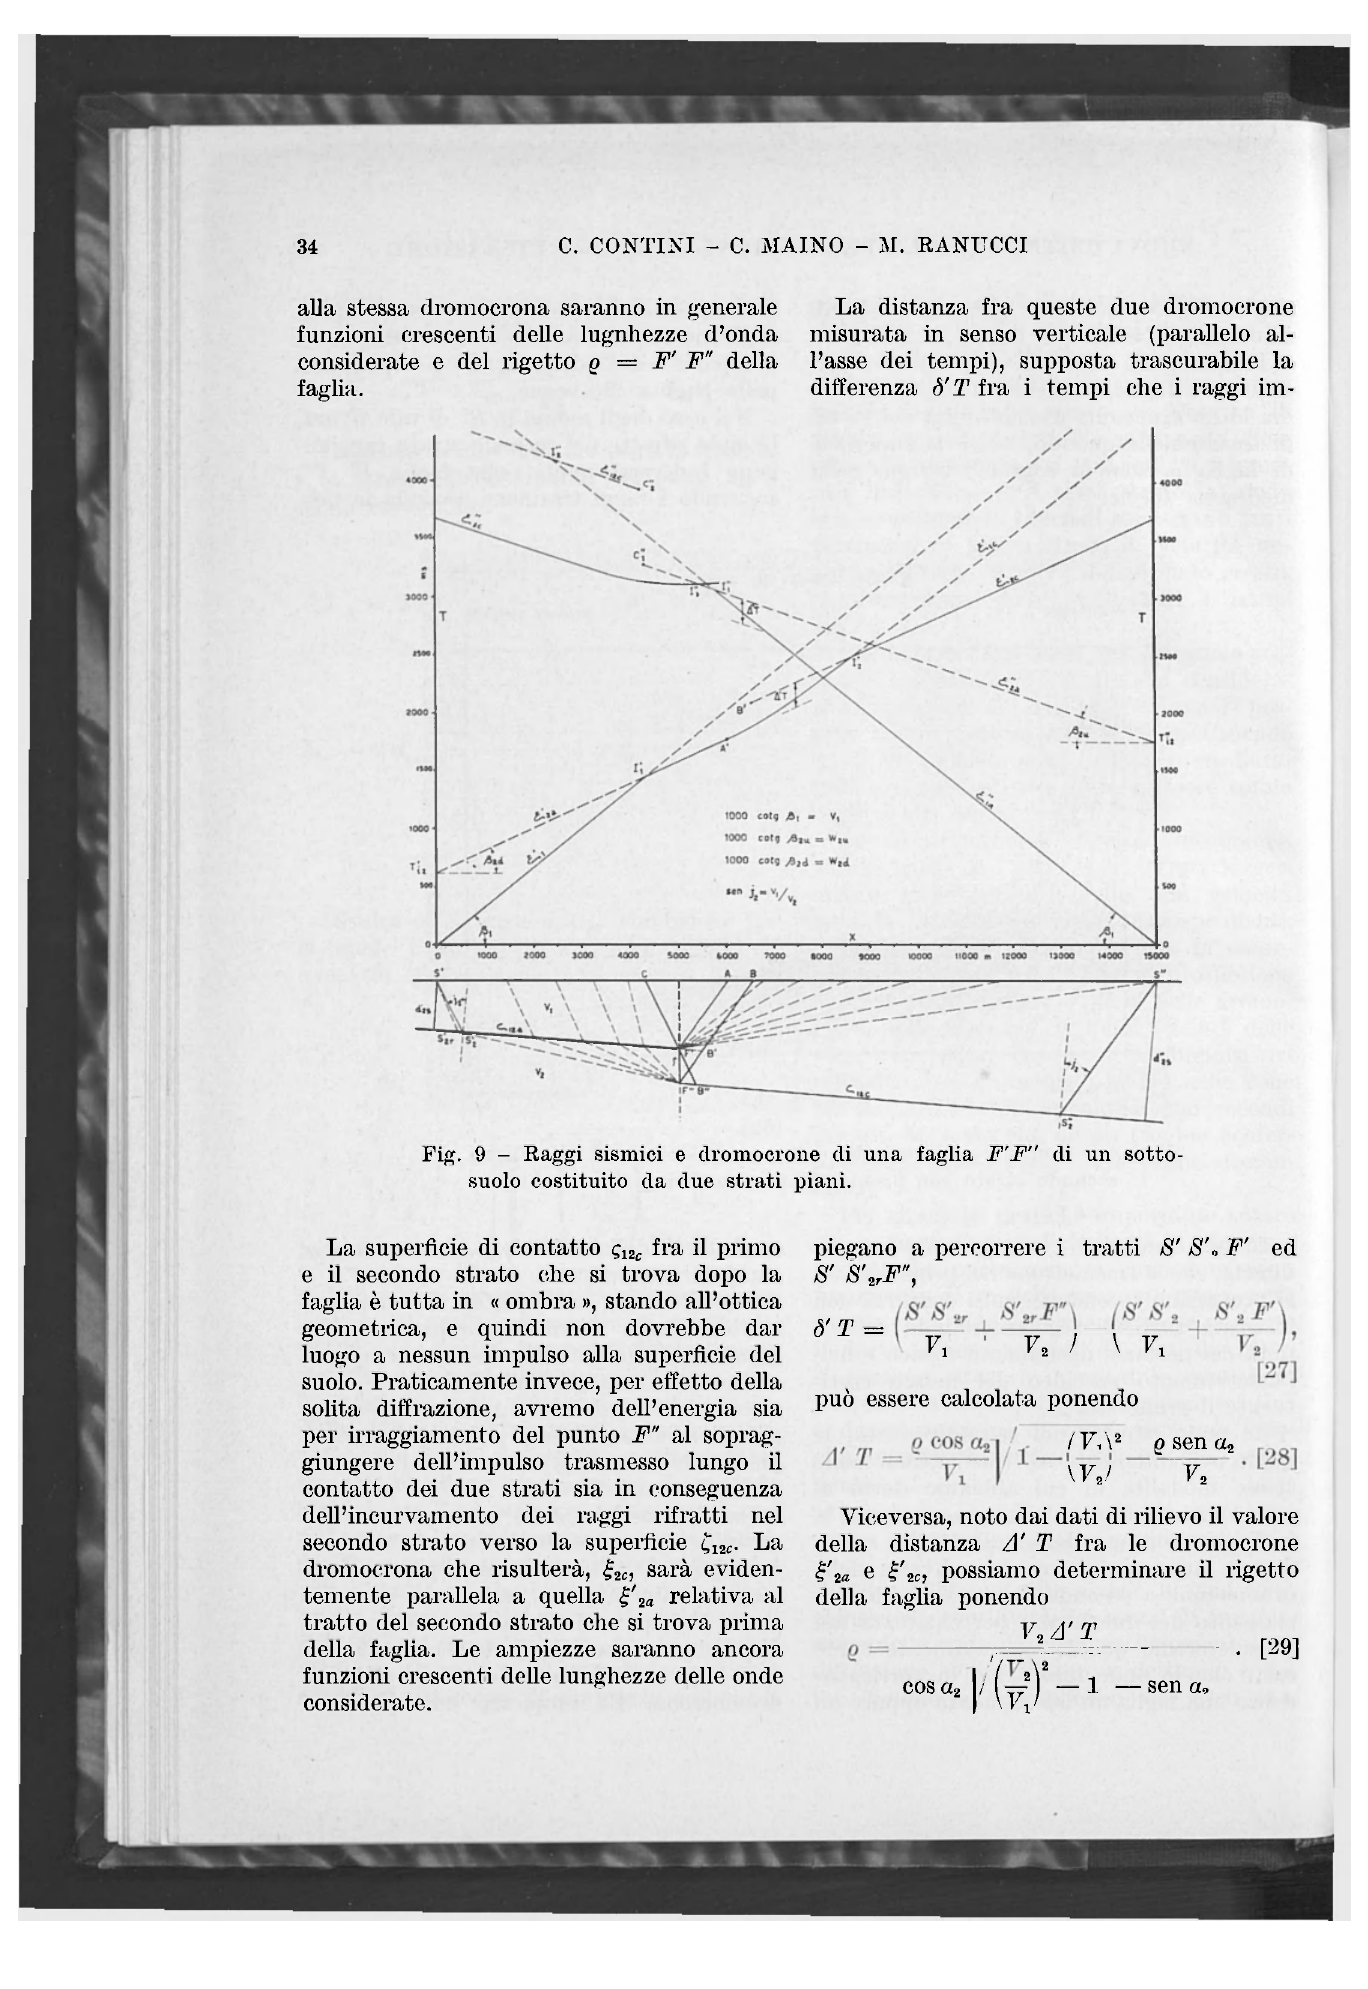
Fig. 9 - Raggi sismici e dromocrone di una faglia F'F" di un sotto- suolo costituito da due strati